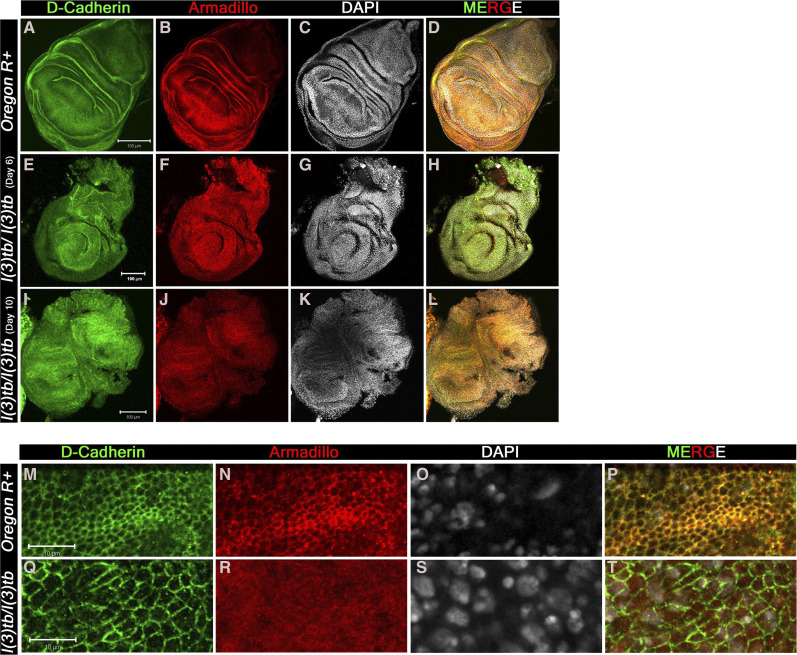
Tumor caused in the homozygous l(3)tb mutant completely alters the distribution patterns of DE-cadherin and Armadillo. Confocal images of 3rd instar larval wing imaginal discs immunolabeled to visualize the altered distribution pattern of cadherin-catenin complex proteins. Tumor caused in the homozygous l(3)tb mutant completely altered the distribution pattern of both, trans-membranous protein DE-cadherin (A, E, I, M, Q) and Armadillo (β-Catenin, B, F, J, N, R) adherens junction proteins. Alteration of both proteins is more pronounced in the wing imaginal discs from mutant larva during extended larval life (I, J) than in the early wing imaginal disc (E, F) as compared to distinct pattern of DE-cadherin (A) and Armadillo (B) in the wild type wing imaginal discs. Armadillo is a binding partner of trans-membranous protein DE-cadherin having roles in cell adhesion and regulate tissue organization and morphogenesis. Merged images also substantiate the altered distribution of both junctional proteins in the homozygous mutant (H, L) as compared to the wild type (D) where co-localization is indicated by yellow pattern. Higher magnification of wing imaginal disc (pouch region) demonstrate altered distribution pattern of DE-cadherin (Q) and Armadillo (R) in homozygous l(3)tb mutant as compared to wild type (N, R). Increase in cell size seen in homozygous l(3)tb mutant (Q) as compared to wild type (M). Complete loss of Armadillo staining observed in homozygous l(3)tb (R) whereas normal pattern seen in wild type wing disc (N). Chromatin size also altered in homozygous l(3)tb (S) as compared to wild type (O). Wild type shows clear co-localization of DE-cadherin and Armadillo (P), while there is complete loss of co-localization in homozygous l(3)tb wing imaginal discs (T). Scale bar represents 100 µm (A to L) and 10 µm (M to T).